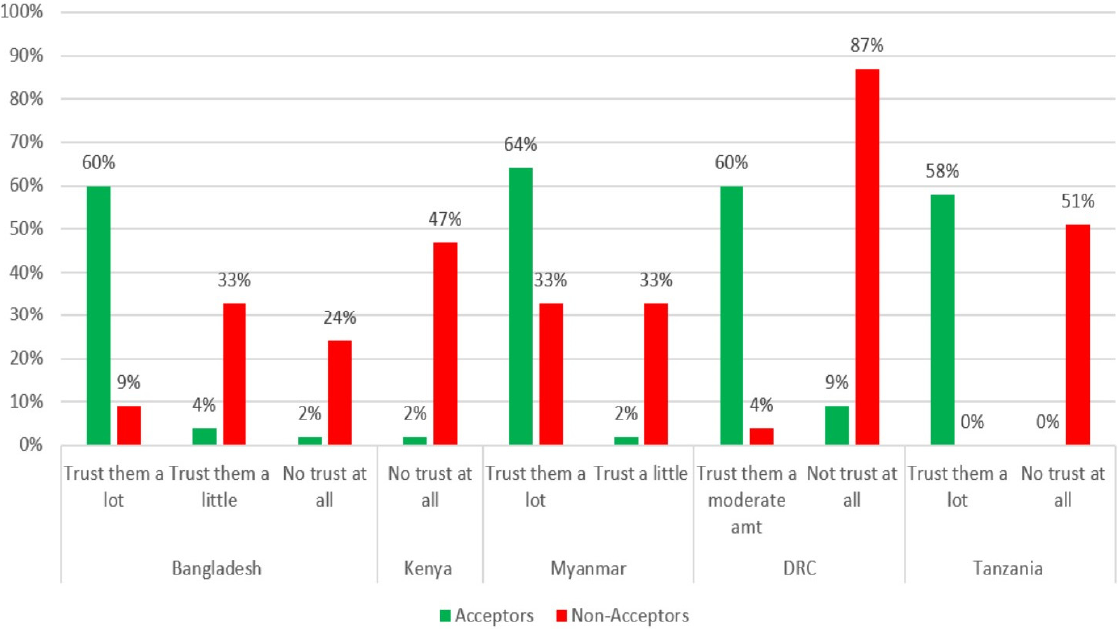
Figure 2. Acceptors’ and Non-acceptors’ trust in COVID-19 vaccine by country.